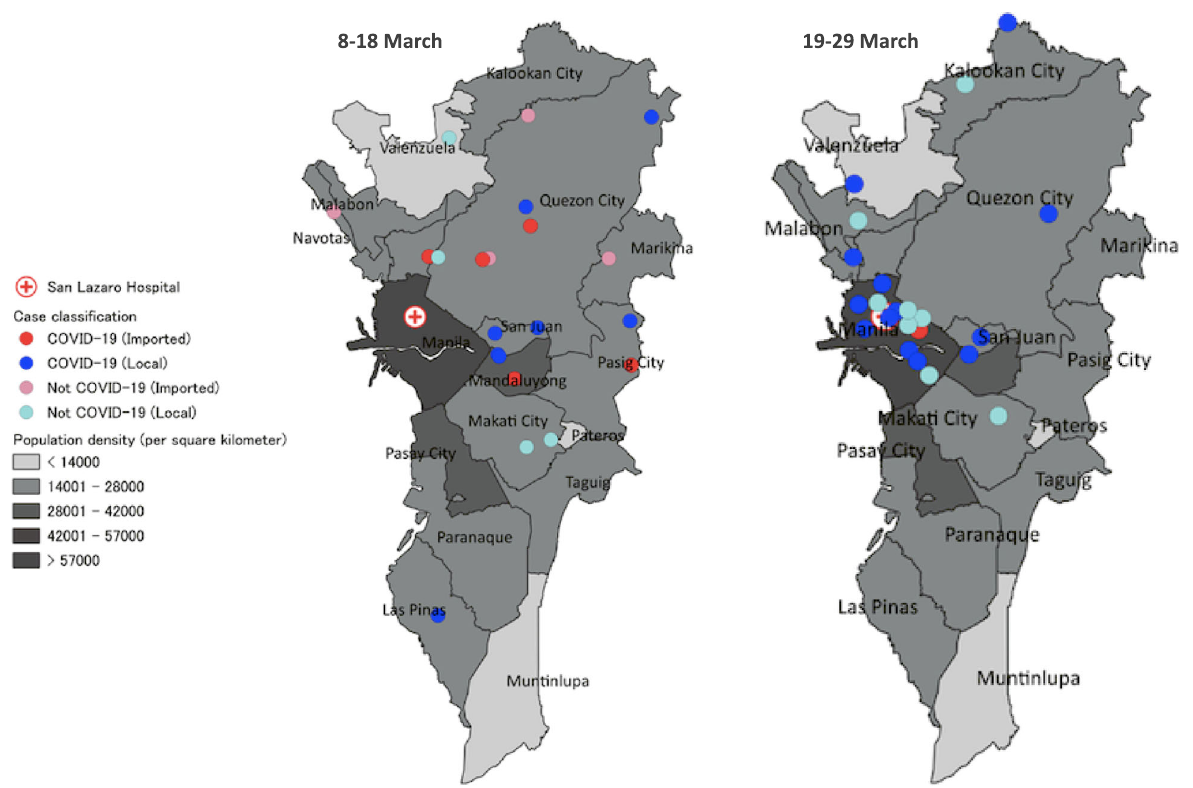
Fig. 2 Residence of suspected and confirmed COVID-19 individuals if resident in the National Capital Region of Metropolitan Manila admitted during 8 – 18 March (left) and 19 – 29 March (right). Twenty-two individuals were admitted during Mar. 8 – 18, of whom 14 were confirmed COVID- 19 (imported [5] vs. local [9]). Twenty-three individuals were admitted during Mar. 19 – 29 of whom 15 were confirmed COVID-19 (imported ( n = 1) vs. local [ n = 14]). Excludes population not resident in Metro Manila ( n = 21) or admitted before March 8 ( n = 34). Dots overlap in the case of identical or similar residence and hence a separate dot is not visible for every